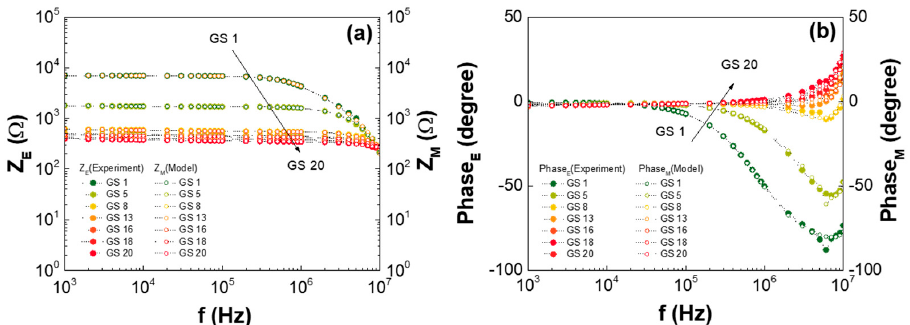
Figure 6. GS impedance characteristics for various GSes and GO concentrations; ( a ) magnitude and ( b ) phase of the measured and calculated impedances.